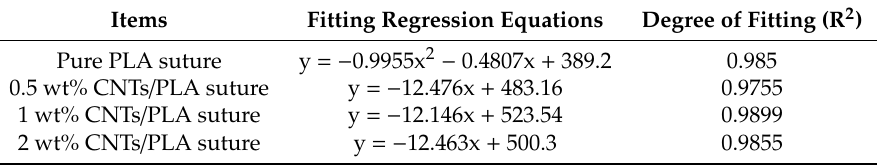
Table 3. Fitting regression equations of breaking strength(y) and degradation time(x).